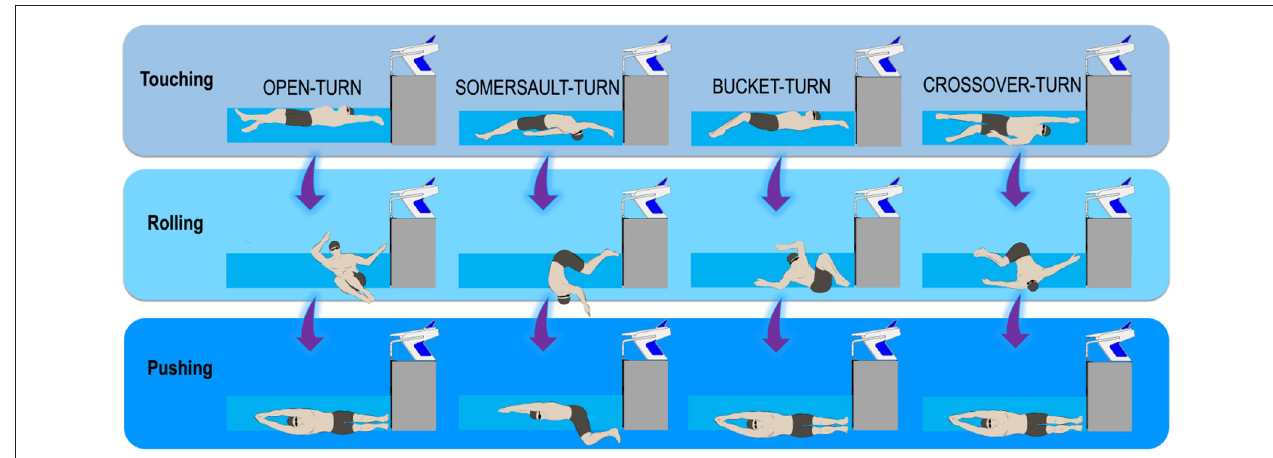
FIGURE 1 | Backstroke to breaststroke turning techniques are distinguished by the different body orientations of the swimmers throughout the touching, rolling and pushing-off phases.